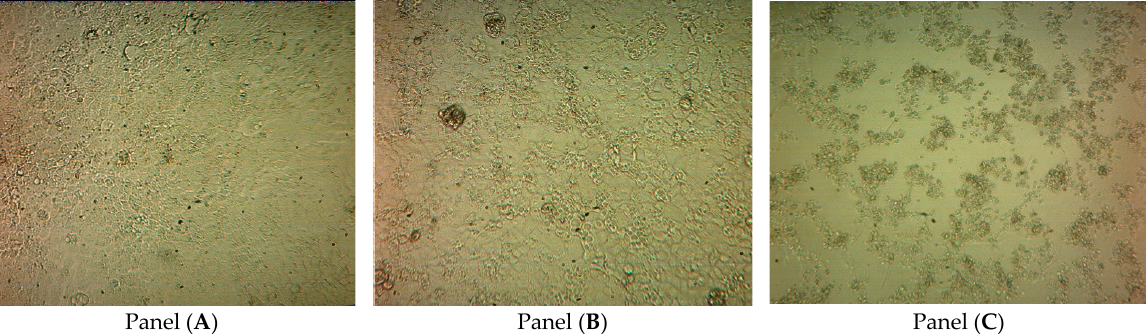
Figure 6. Micrographs displaying the time course of the development of SARS-CoV-2-induced cytopathic effects CPE in the Vero E6 cell monolayer. The CPE were visually scored for each well in a blinded fashion by two independent observers. Wells with 0, 25, 50, 75, and 100% cells exhibiting CPE or viability loss were scored, respectively, CPE–, CPE+, CPE++, CPE+++, and CPE++++. The photo in Panel ( A ) shows non-infected cells (no-virus control) after 72 h of incubation (no CPE or dead cells). Panels ( B ) and ( C ) show, respectively, cells inoculated with 10 3 TCID 50 /mL 36 and 72 h post-infection. About 50% of cells in Panel B exhibit CPE or loss of viability (score: CPE++). In Panel ( C ), all cells are dead (score: CPE++++). The photos were taken using an inverted microscope (×200 magnification; Leitz Diavert, Wetzlar, Germany).